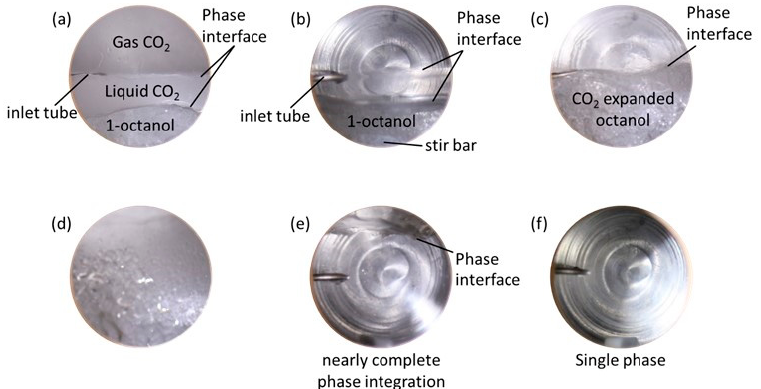
Figure 3. Phase equilibria of 1 ‐ octanol with CO 2 as the pressure increased at 23 °C. ( a ) 1 ‐ octanol with liquid CO 2 being added to the cell. A gas phase CO 2 layer formed above the liquid phase CO 2 . ( b ) 1 ‐ octanol with liquid and gas CO 2 phases above it. ( c ) 1 ‐ octanol was expanded by the CO 2 with liquid CO 2 above it. ( d ) The density of the 1 ‐ octanol and the CO 2 are both 824 kg/m 3 at 8.96 MPa. The 1 ‐ octanol formed droplets in the CO 2 . ( e ) The liquid CO 2 was denser than the 1 ‐ octanol, and the 1 ‐ octanol was the top phase at greater than 8.96 MPa. ( f ) The 1 ‐ octanol and the liquid CO 2 are single ‐ phase.